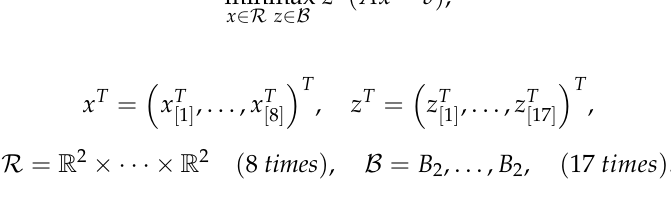
Figure 1. Example 1, Top Left: N = 5; Top Right: N = 10; Bottom Left: N = 30; Bottom Right: N =